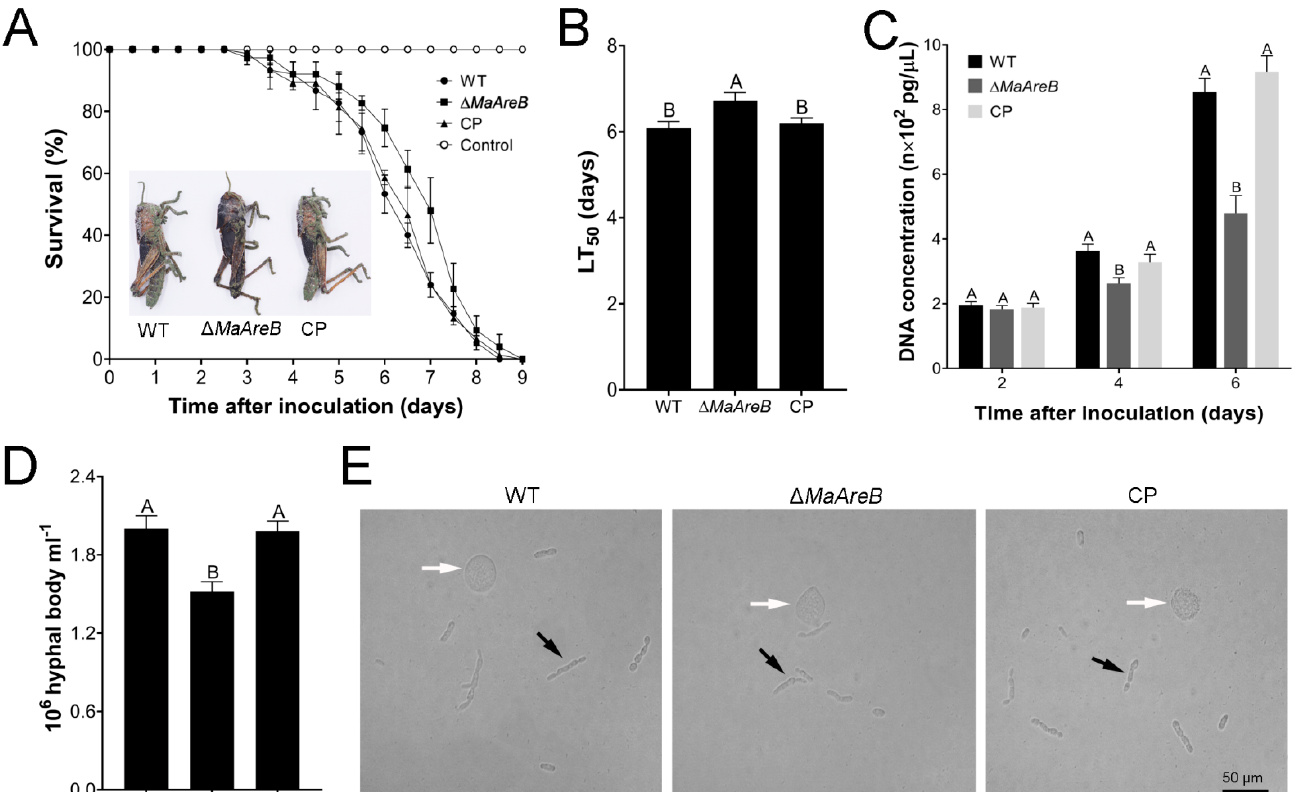
Figure 6. Loss of MaAreB reduced the virulence in topical inoculation. ( A ) Survival rates of locusts after infection with the WT, ∆ MaAreB and CP strains in topical inoculation test, respectively. Locust cadavers killed by each strain were cultured at 28 °C for 8 days. ( B ) LT 50 s of fungal strains in topical inoculation test. ( C ) DNA concentrations of M. acridum in hemolymph of locusts infected with the WT, ∆ MaAreB and CP strains for 2, 4 and 6 days in topical inoculation test. For each treatment, 600 μ L blood was taken from 20 locusts (30 μ L per locust) to extract the genomic DNA. The fungal DNA concentrations were determined using quantitative PCR with primer pair of ITS-F/ITS-R (Table S1) as described previously [39]. ( D ) The number of hyphal bodies in locust hemolymph by topical inoculation at 6 dpi. dpi, days post inoculation. ( E ) Microscopic images of hyphal bodies in locust hemolymph by topical inoculation at 6 dpi. The white arrows indicate the locust blood cells, and the black arrows indicate the hyphal bodies. A&B, p < 0.05 (Tukey’s HSD). The p -values in Figure 6B-D are listed in supplementary Table S3.